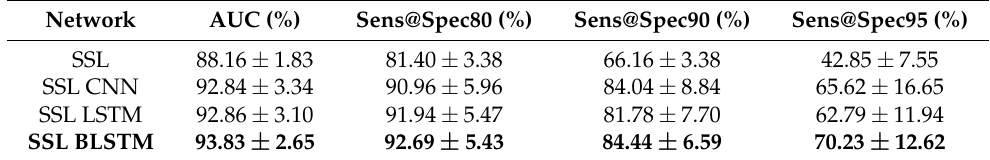
Table 2. Mean and standard deviation of ROC AUC and Sensitivity (at given Specificity rates). All metrics have been obtained using a 5-fold cross validation. The best performing system is highlighted in